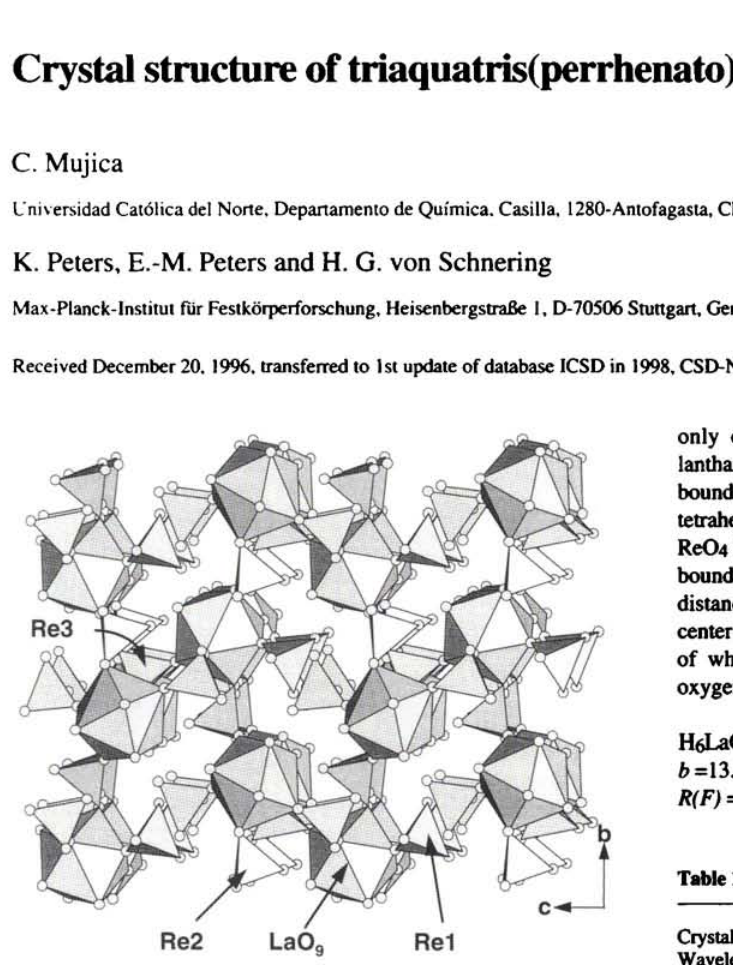
Table 1. Parameters used for the X-ray data collection